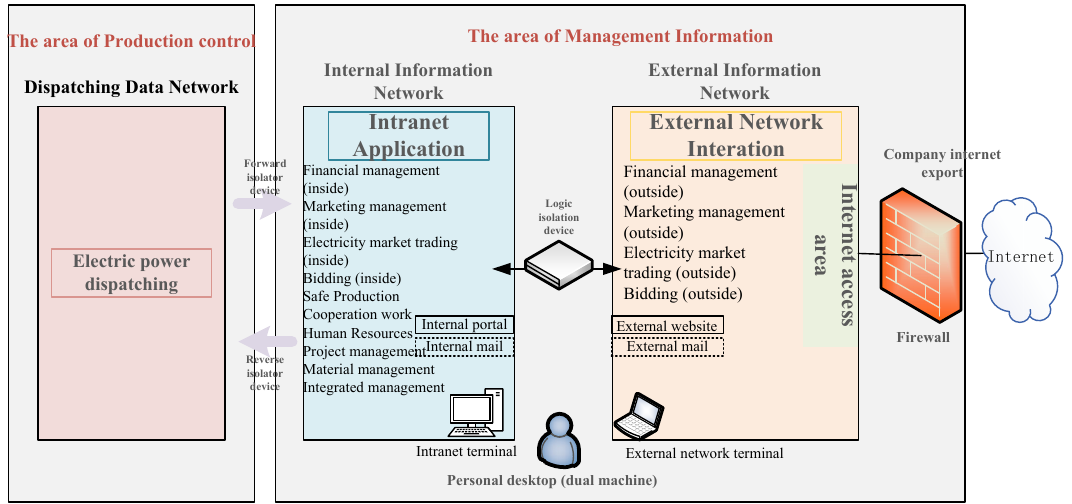
Figure 1. The three traditional defenses of information systems in the smart